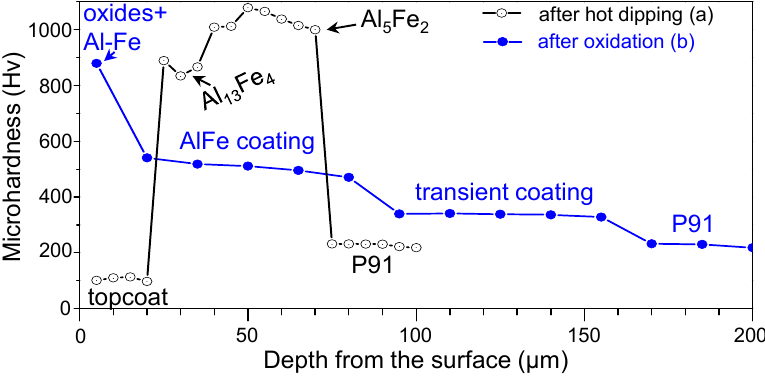
Figure 6. Vickers microhardness variation along the depth for Al-hot dipped P91 steel: ( a ) before oxidation; ( b ) after oxidation at 800 °C for 100 h.